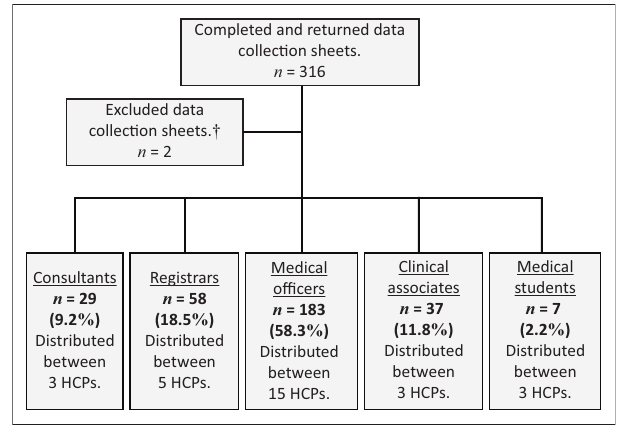
Completed and returned data collec(cid:17)on